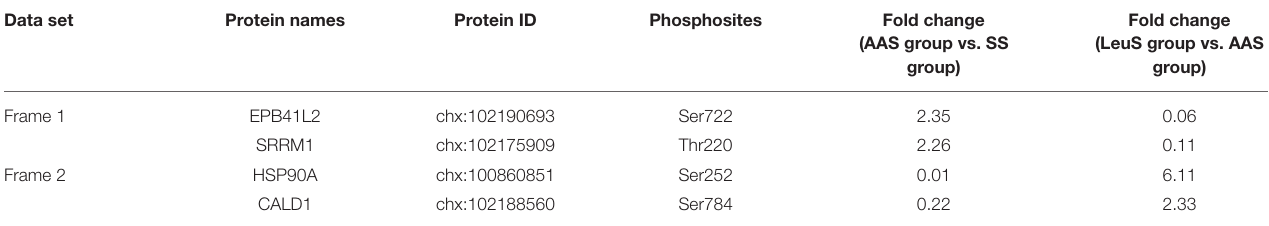
TABLE 3 | Relative quantitative data of phosphosites responding to leucine signal.